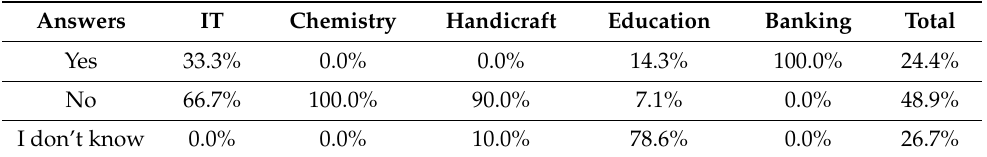
Table 7. Distribution of awareness of expenses (royalties) paid for the use of technologies or intellec- tual property.